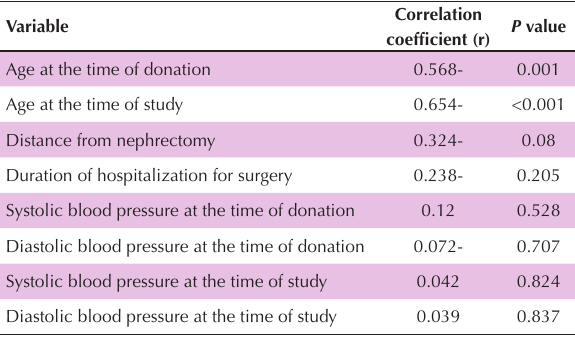
Table 2. Relationships of age, distance from nephrectomy, and clinical results of donors with GFR during the examination Variable